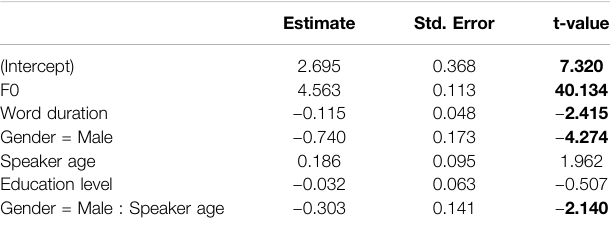
TABLE 3 | Linear mixed-effects regression summary table for H1*-H2*. Absolute t-values larger than 2 are regarded to indicate signi fi cance and are highlighted in bold.